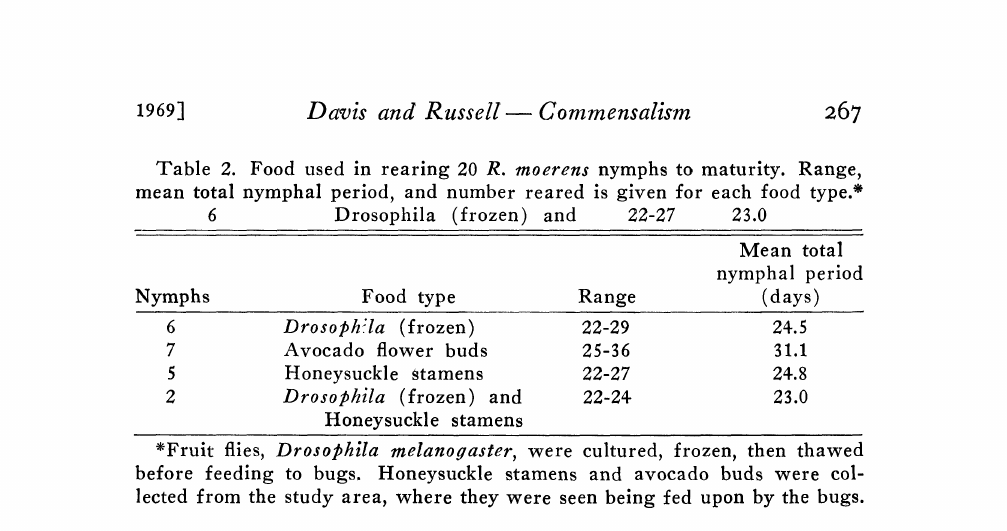
Table 2. Food used in rearing 20 R. moerens nymphs to maturity. Range, mean total nymphal period, and number reared is given for each food